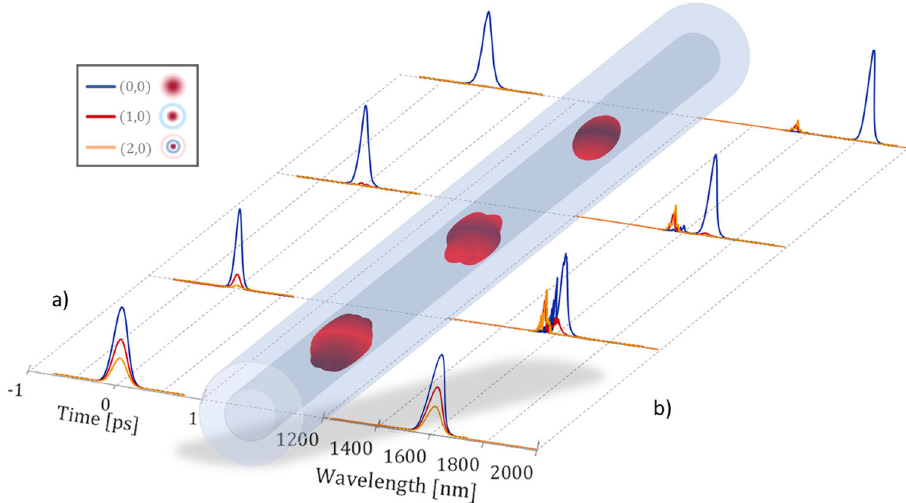
Fig. 5 Spatiotemporal soliton formed from an input 235 fs pulse. The soliton is composed by three axial modes, propagating over 120 m of graded-index (GRIN) fi ber, for the optimal input energy of 2.5 nJ. (a) modes power, (b) modes spectra.